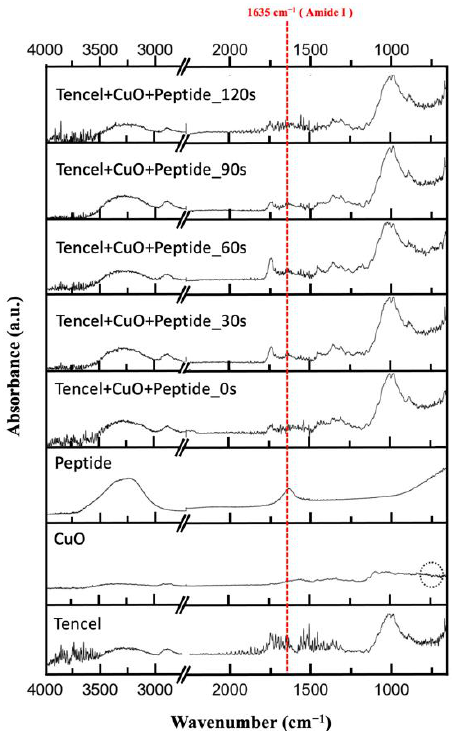
Figure 3. FT-IR spectra of nano-CuO/Tencel membranes with different plasma treatment times.